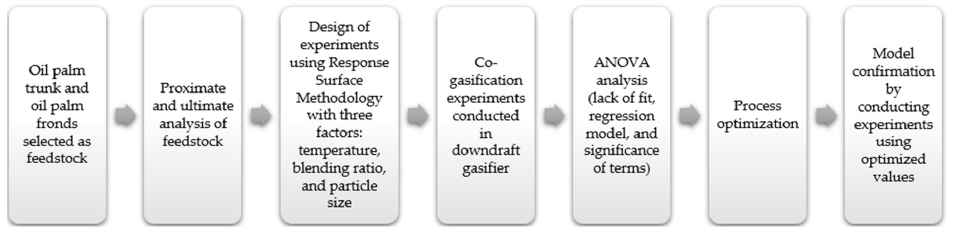
Figure 5. Approach for optimization of co-gasification of biomass.